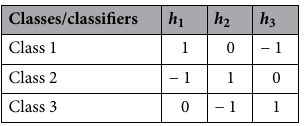
Table 3. ECOC with one-versus-one